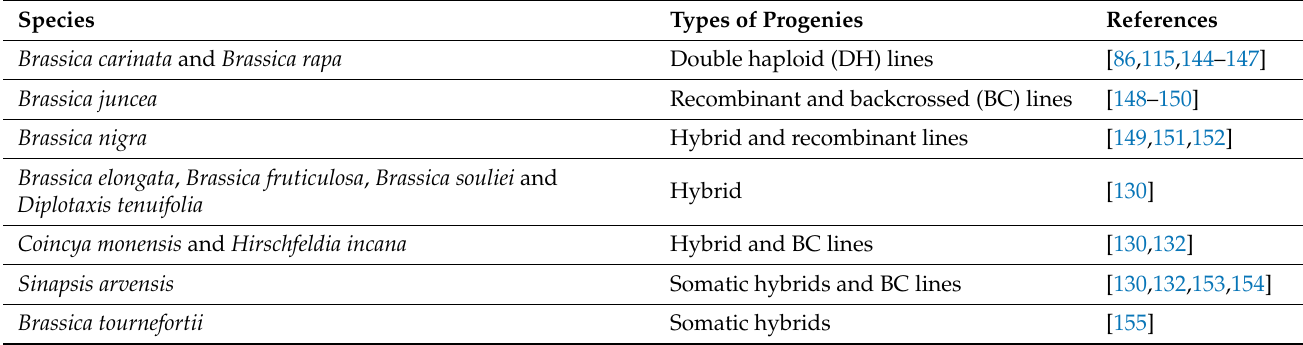
Table 3. Successful Brassica napus progenies hybridized/developed with selected Brassicaceae species having blackleg resistance in cotyledon